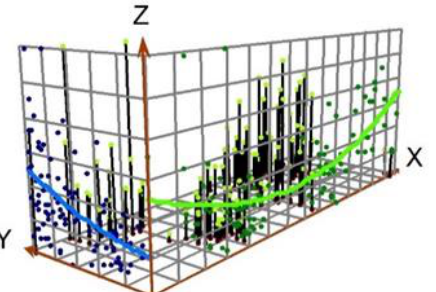
Figure 2 . Trend analysis which can show the overall distribution law